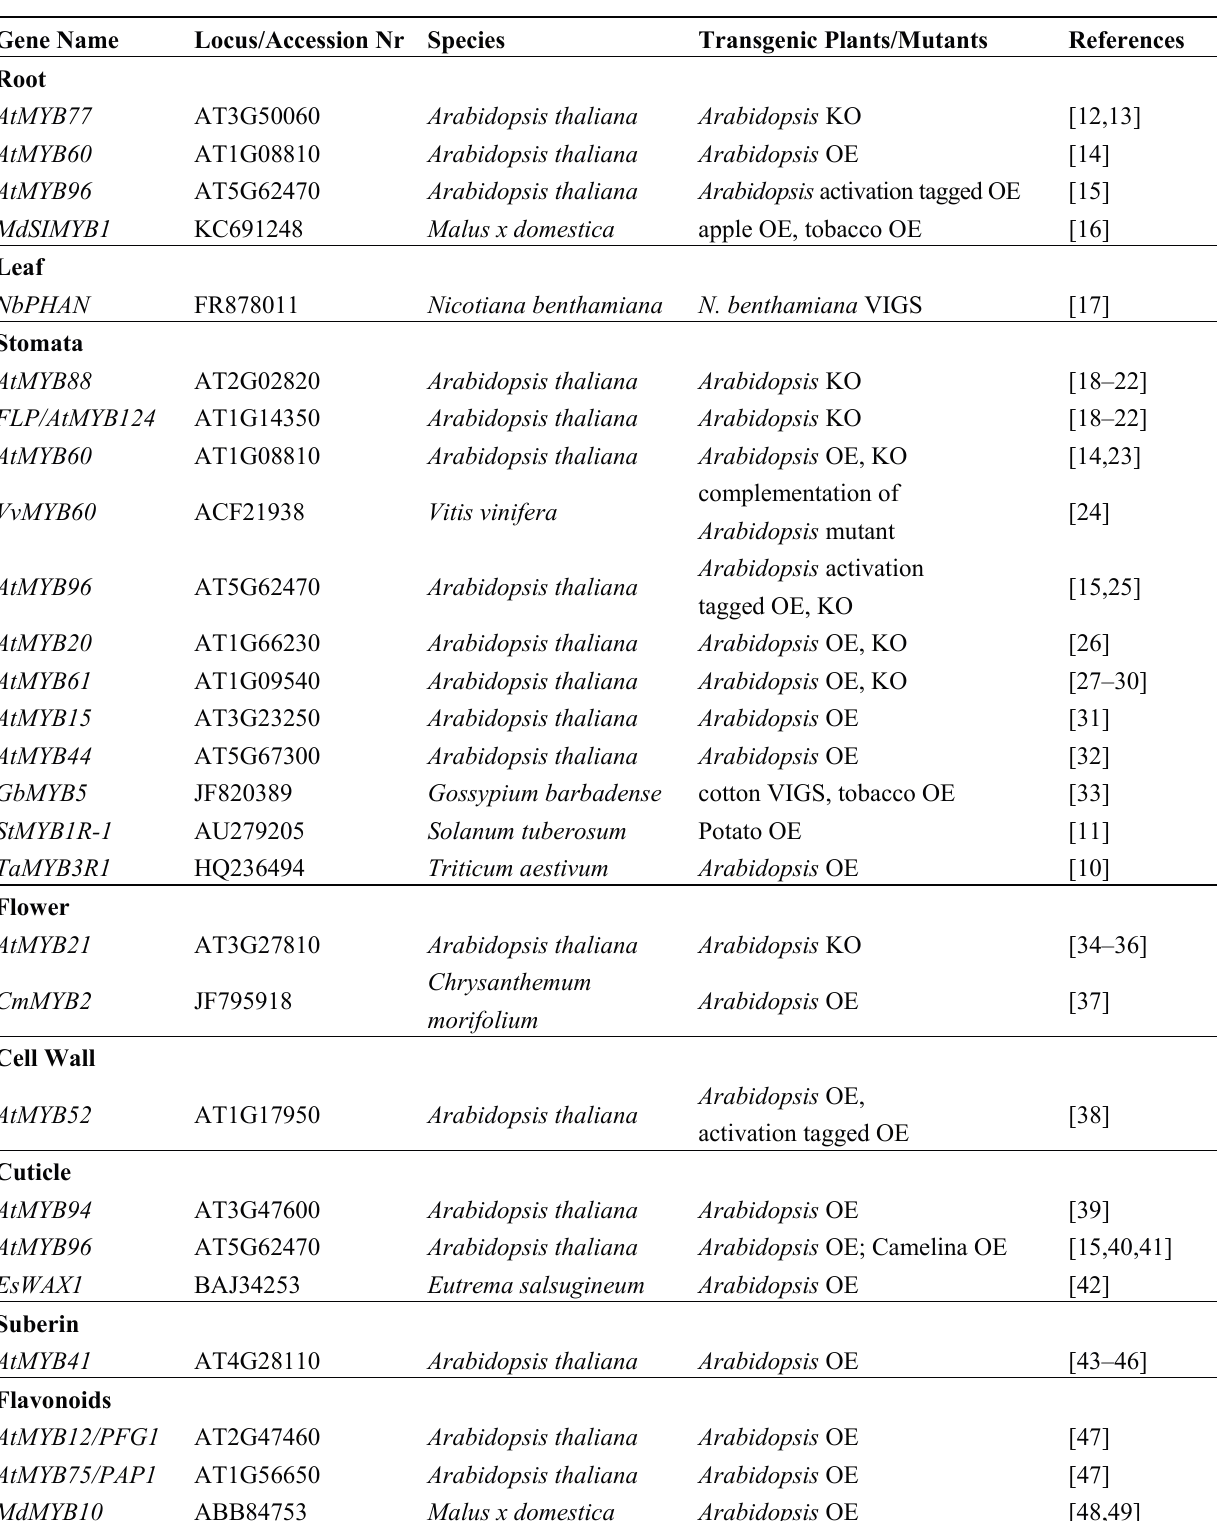
Table 1. MYB genes involved in drought response. The different functional analyses on MYB genes were performed on knockout mutants (KO), or on overexpression (OE), virus-induced gene silencing (VIGS) and RNA-interference (RNAi)